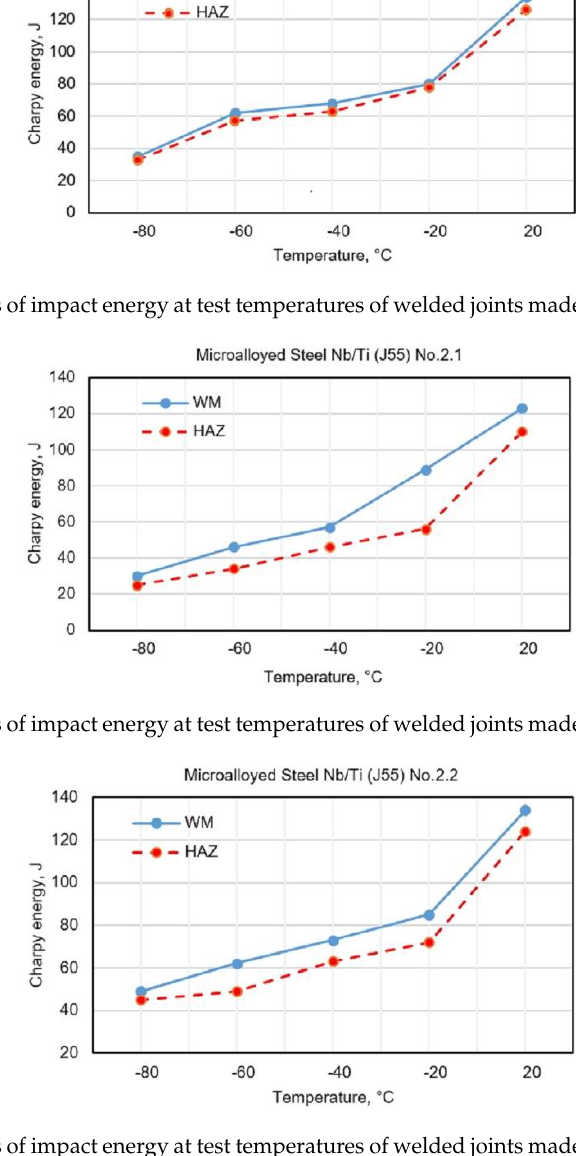
Figure 6. Test results of impact energy at test temperatures of welded joints made with electrode No.2.2.